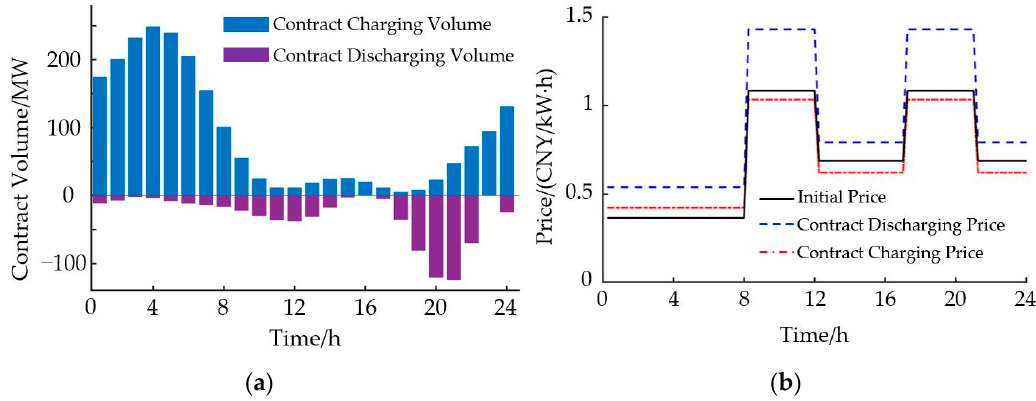
Figure 5. Contract results reached by market subjects. ( a ) results of contract volume; ( b ) results of contract price.